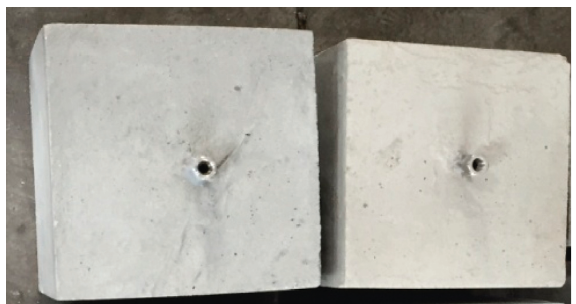
Figure 2: Molding experimental